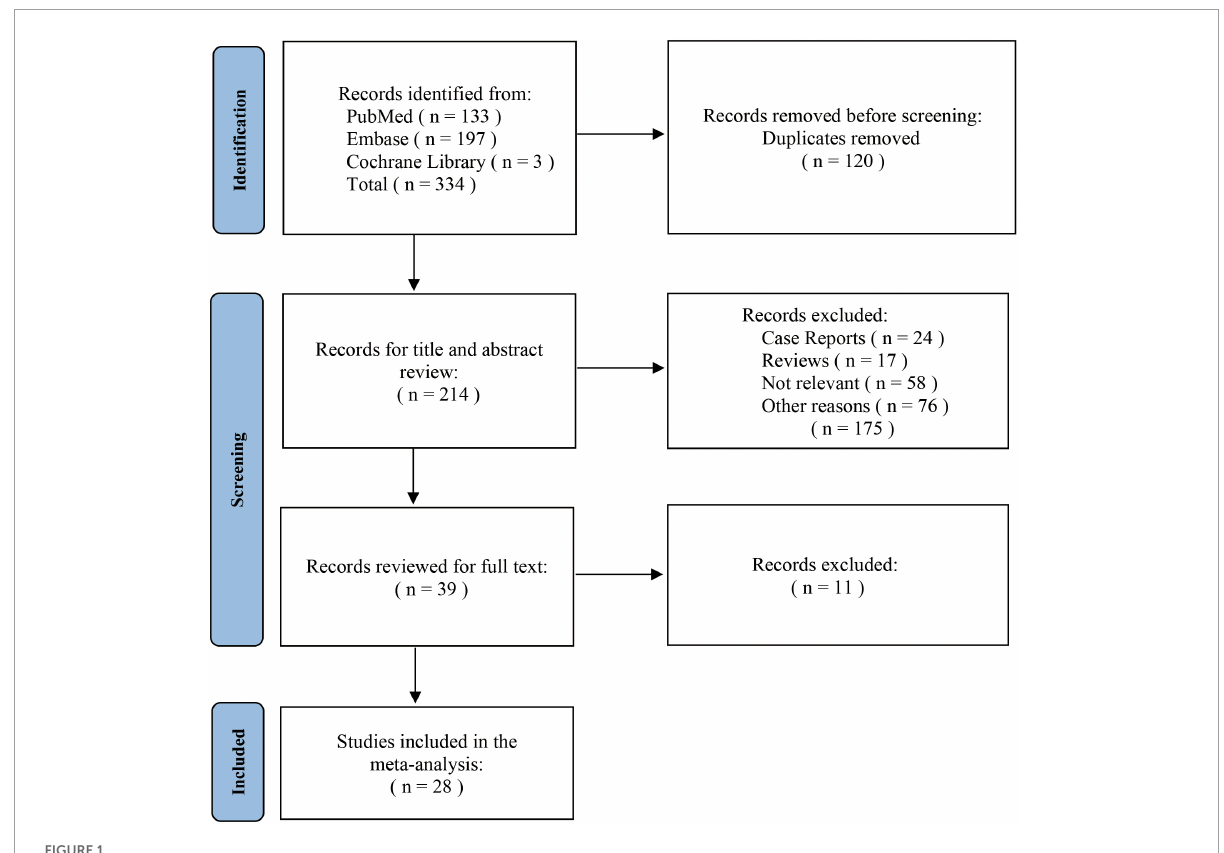
FIGURE1 Flow chart illustrating the process of selecting